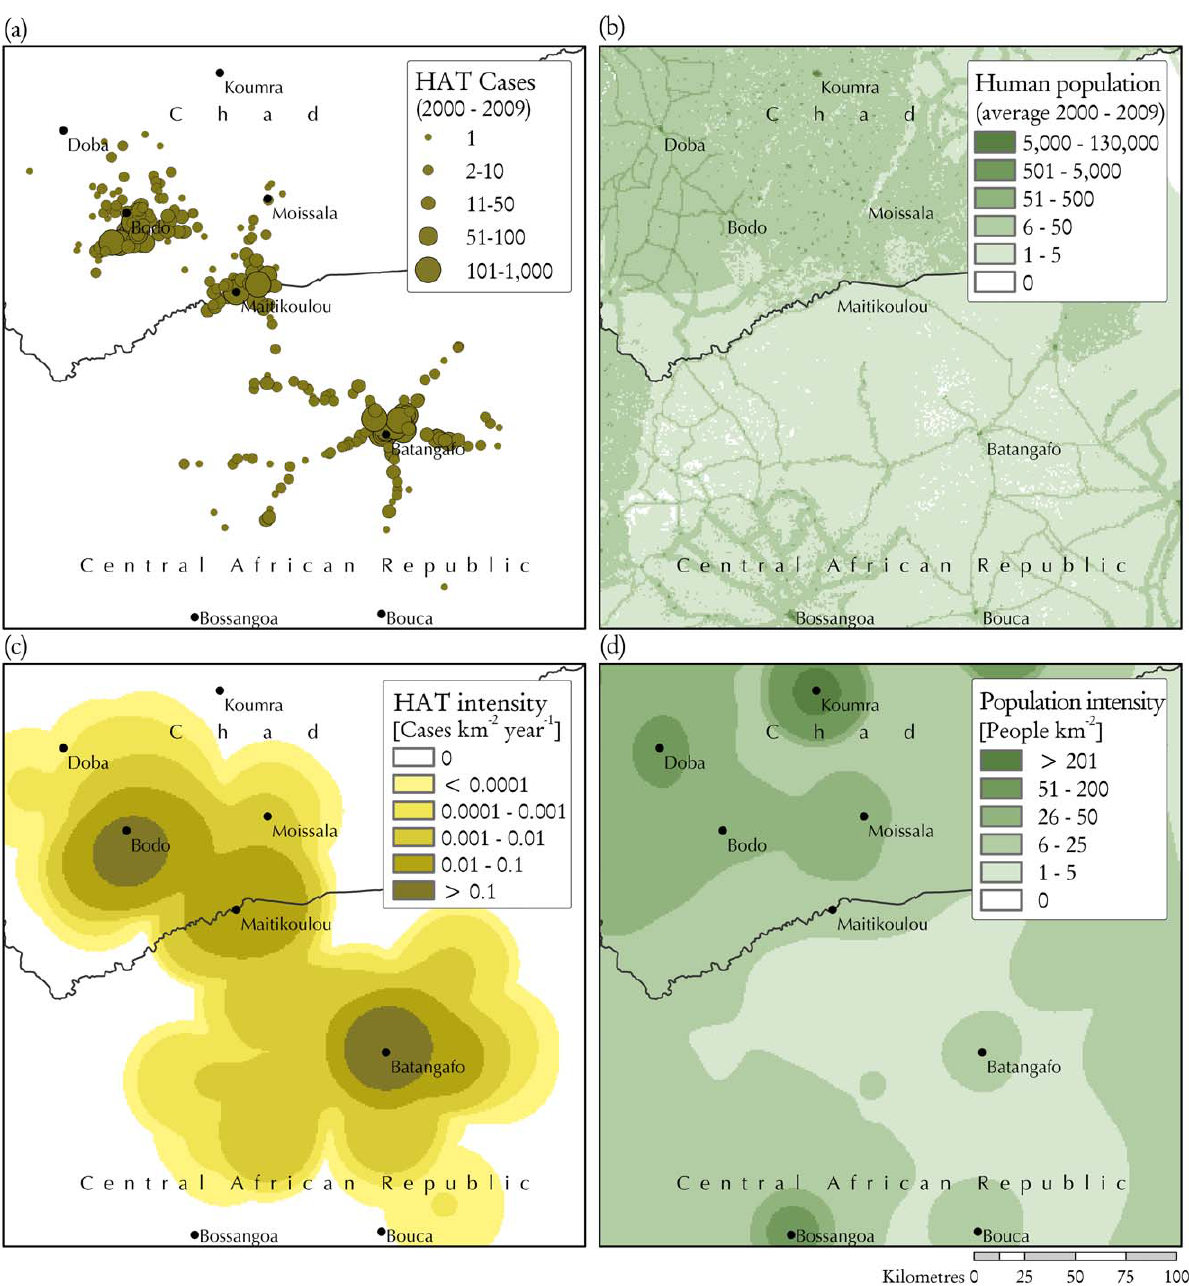
Figure 2. The foci of Bodo-Moissala in Chad and Batangafo-Maitikoulou in Central African Republic. (a) Distribution of HAT cases; (b) Average population distribution (Landscan); (c) Annual intensity of HAT cases as derived from (a) through spatial smoothing; (d) Population intensity as derived from (b) through spatial smoothing. Figure 3, Figure 4 and Figure 5 respectively. Country-level risk (Table 2 and Table 3). Areas at ‘very high’ to ‘moderate’ risk maps are provided in Supporting Information (Maps S1). Focus account for 719 thousand km 2 (46.3%) and areas at ‘low’ to ‘very low’ risk account for the remaining 833 thousand km 2 (53.7%).